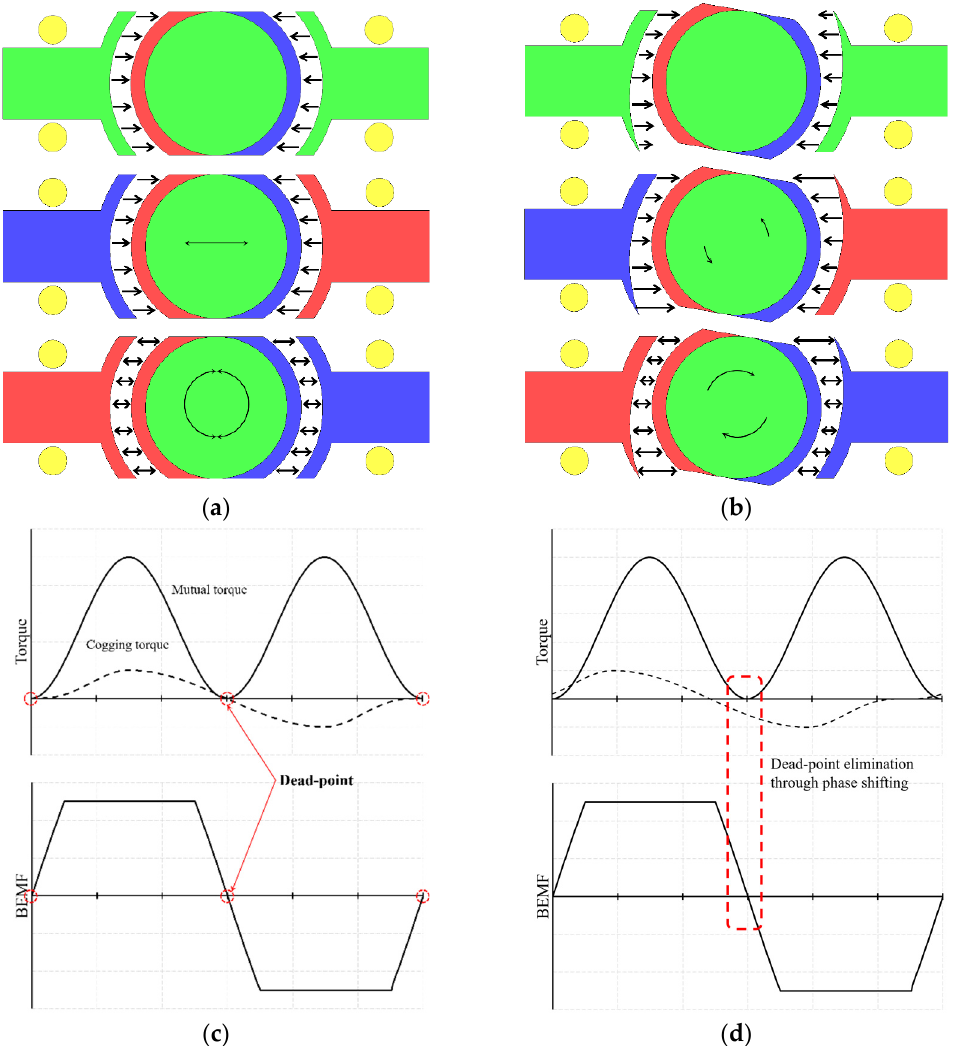
Figure 2. Torque mechanism of single-phase BLDC motor symmetry and asymmetric air-gap ( a ) symmetrical air-gap ( b ) asymmetrical air-gap ( c ) dead-point for symmetry air-gap of single-phase BLDC motor ( d ) dead-point for asymmetric air-gap of single phase BLDC motor.